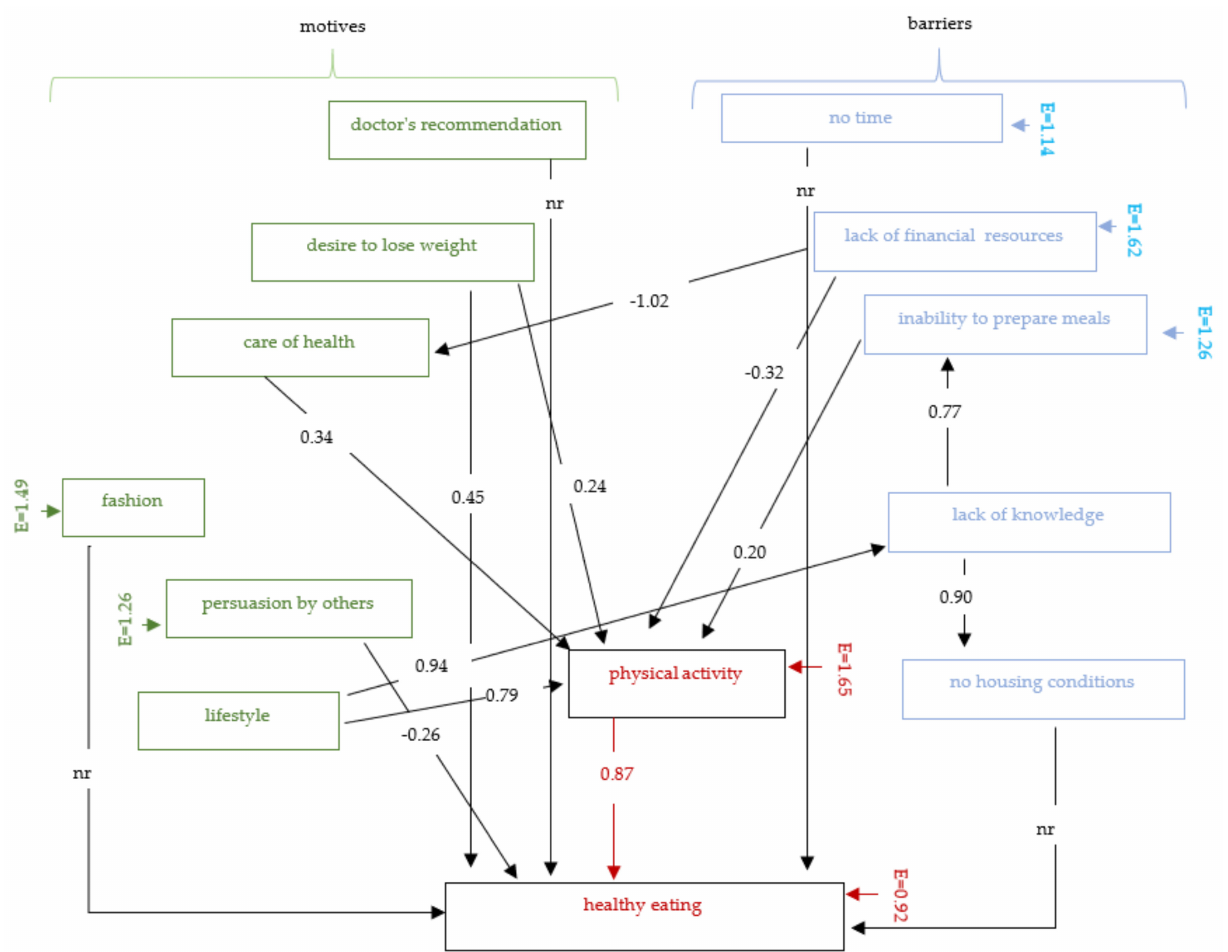
Figure 1. Graphical structural equation modelling: motivations and barriers to healthy eating. nr—not relevant; E—residual variables